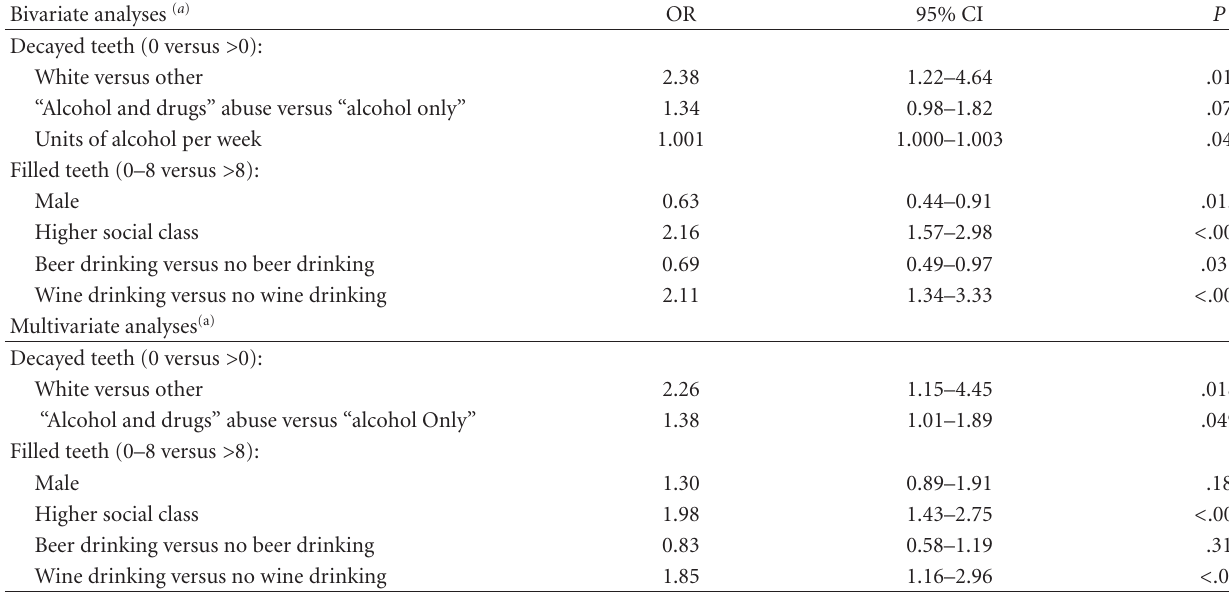
Table 3: Factors associated with decayed teeth and filled teeth (bivariate analyses at 10% level of significance and multivariate logistic regression